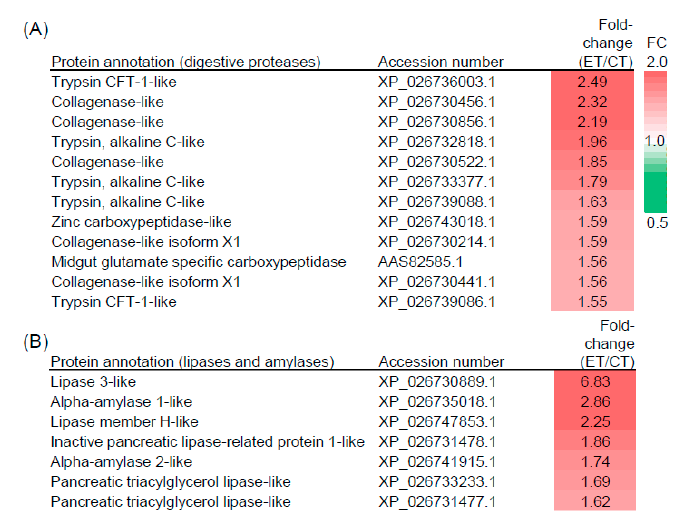
Figure 6. Feeding at elevated temperature increases the abundance of T. ni digestive enzymes. T. ni larvae were reared on WT Arabidopsis plants under CT or ET conditions as described in the main text. T. ni proteins excreted in caterpillar frass were identified and quantified using a tandem-mass tag shotgun proteomics approach. All the proteins listed have putative roles in proteolysis ( A ) or lipid / carbohydrate digestion ( B ) and are more abundant in frass from ET-reared compared to CT-reared larvae (1.5-fold change cutoff for ET/CT).